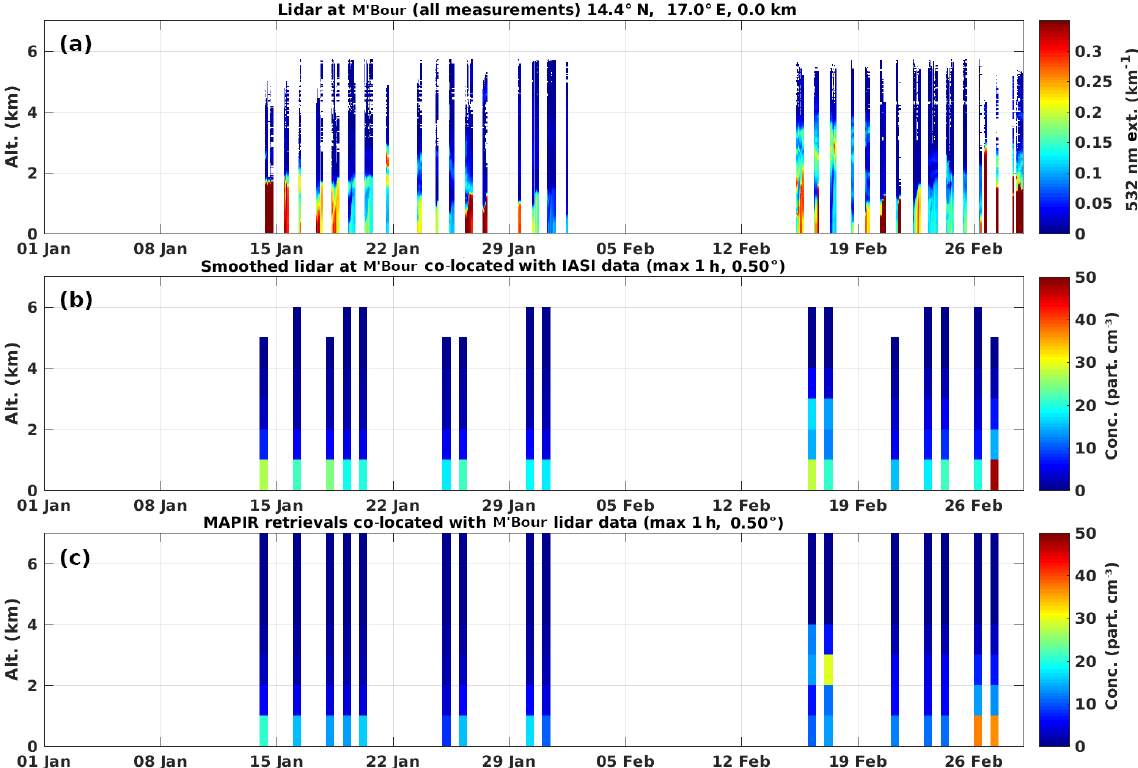
Figure 8. Mineral dust profile comparison at M’Bour site (Senegal) from 1 January to 1 March 2015. Panel (a) gives the lidar data (extinction profiles at 532nm) as provided for this study. In panel (b) , the lidar data smoothed according to Eq. (7) are presented, for those times when there is a co-located MAPIR profile. Panel (c) presents the MAPIR profiles over time averaged around the M’Bour